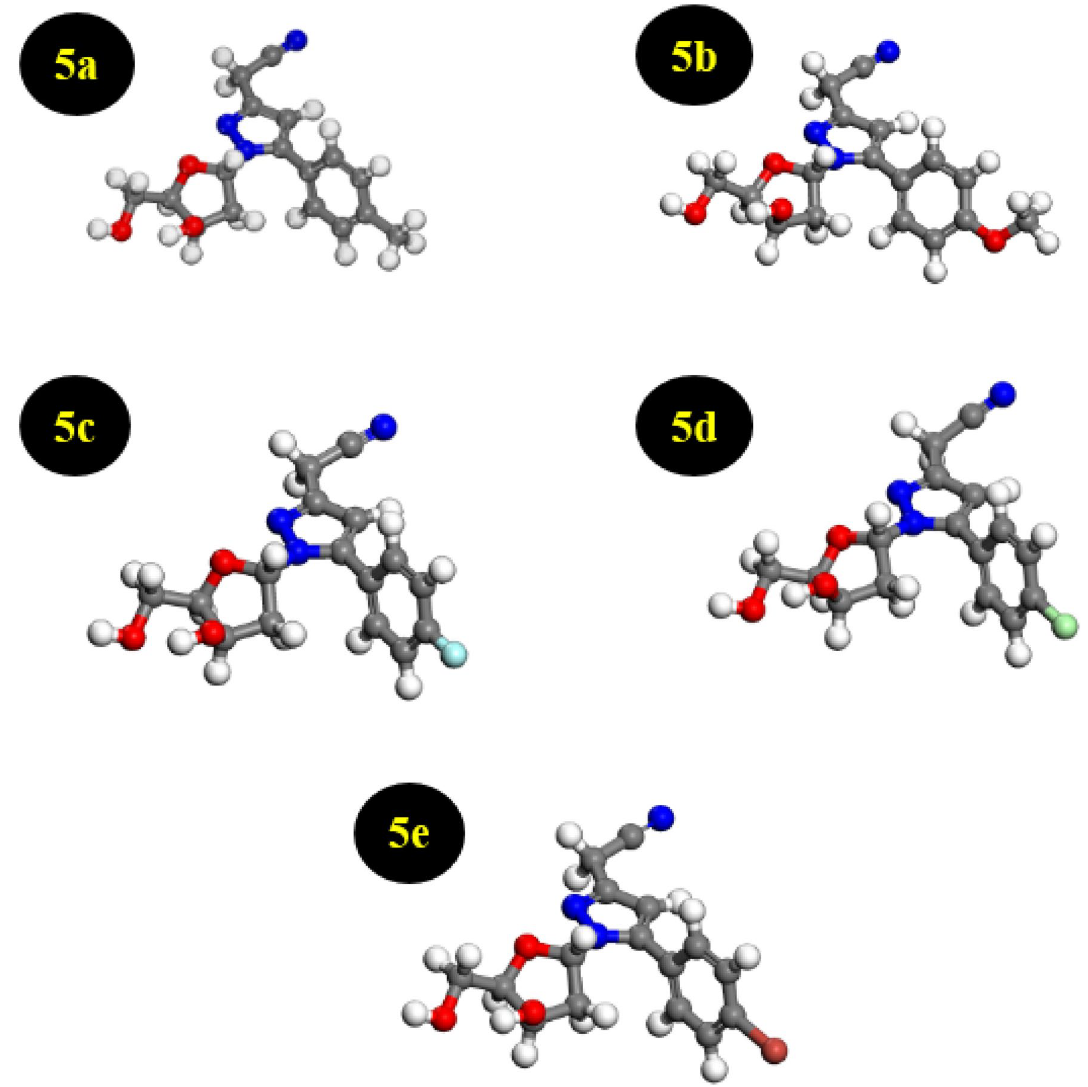
Figure 2. Optimized structures of the pyrazolylnucleosides 5a – e